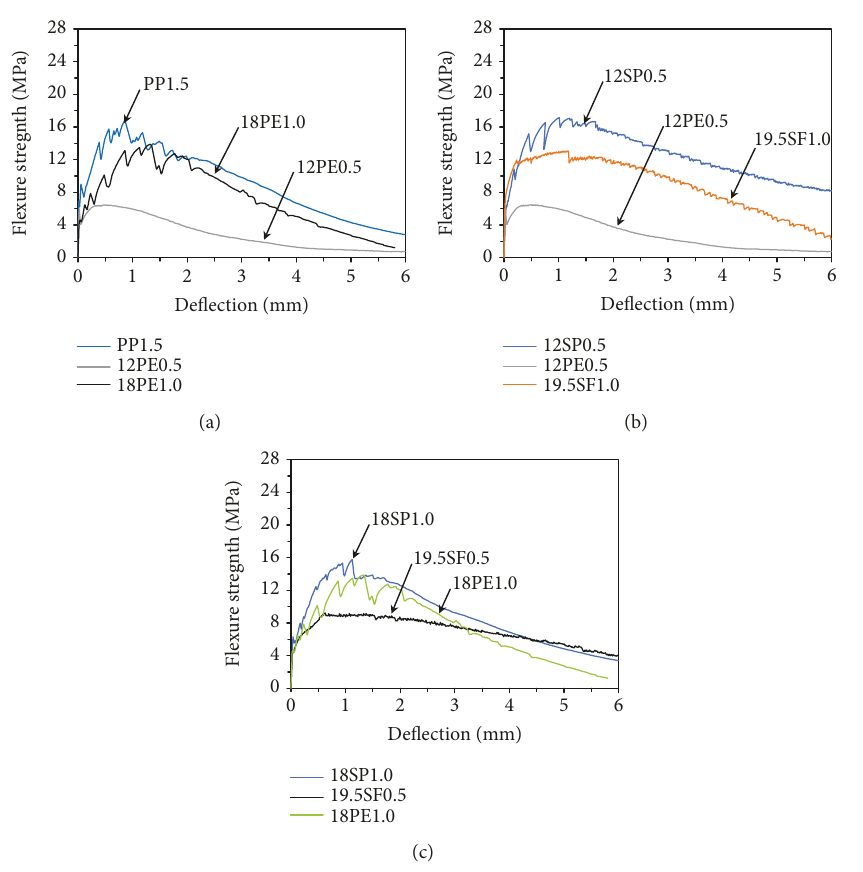
Figure 8: Average fl exural load-de fl ection behavior by various conditions of w/b of 16.4%: (a) U16.4 based on PE fi bers with di ff erent lengths, (b) U16.4 based on steel fi bers with short PE fi bers, and (c) U16.4 based on steel fi bers with long PE fi